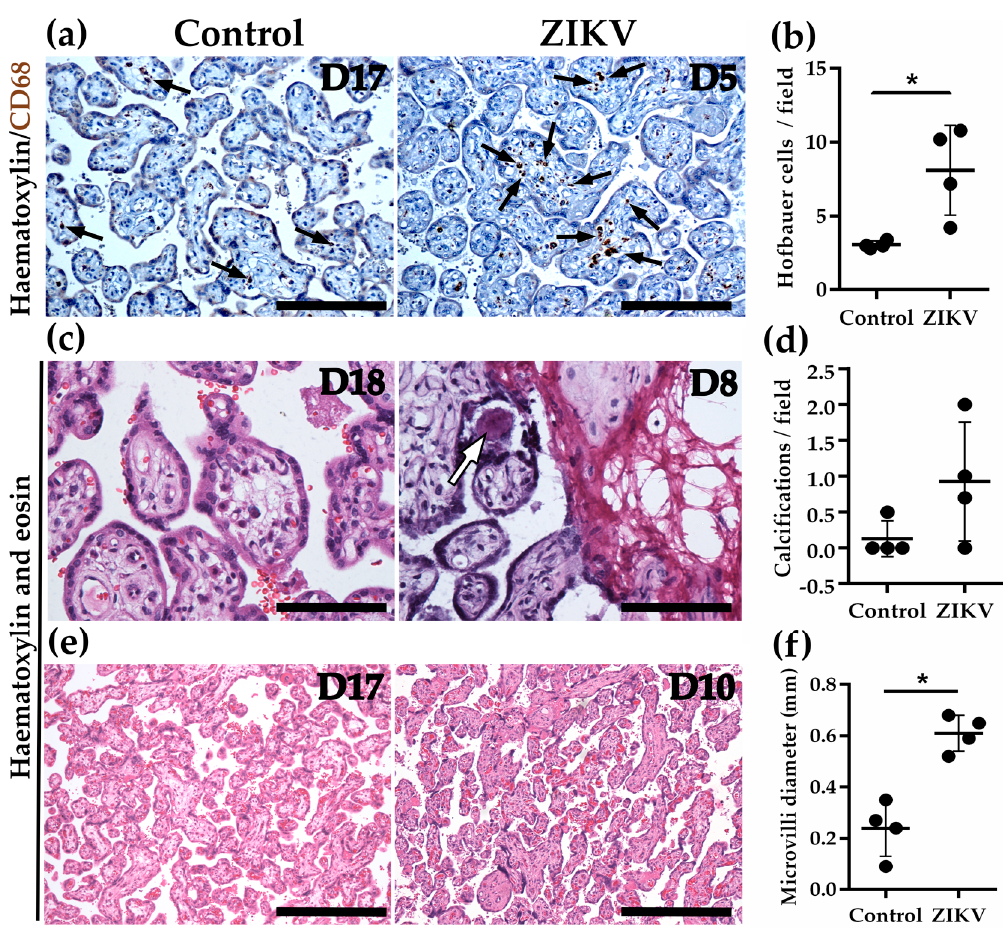
Figure 4. The chorionic villi of ZIKV-infected placentae display Hofbauer cell hyperplasia and a higher mean diameter. ( a ) Hofbauer cells (arrows) in chorionic villi were detected with an antibody against CD68 in slides stained with haematoxylin. Bar, 100 µ m. ( b ) The number of Hofbauer cells was evaluated counting CD68 + positive cells in five optical fields per placenta. Each dot corresponds to the mean value of Hofbauer cells / field present in each placenta. * p = 0.0294. ( c ) Calcification (arrow) present in a chorionic villus detected in a slide stained with haematoxylin and eosin. Bar, 50 µ m. ( d ) Calcifications were counted in five optical fields per placenta. Each dot corresponds to the mean value of calcifications / field present in each placenta. ( e ) The diameter of chorionic microvilli is higher in ZIKV-infected placentae than in the control condition. Bar, 200 µ m. ( f ) The diameter of chorionic villi was measured using the image analysis software Zen (version ZEN 2.3 lite, Carl Zeiss Microscopy, Jena, Germany) in five optical fields of samples from placentae stained with haematoxylin and eosin. Each dot corresponds to the mean diameter of chorionic villi per placenta. * p = 0.0286.